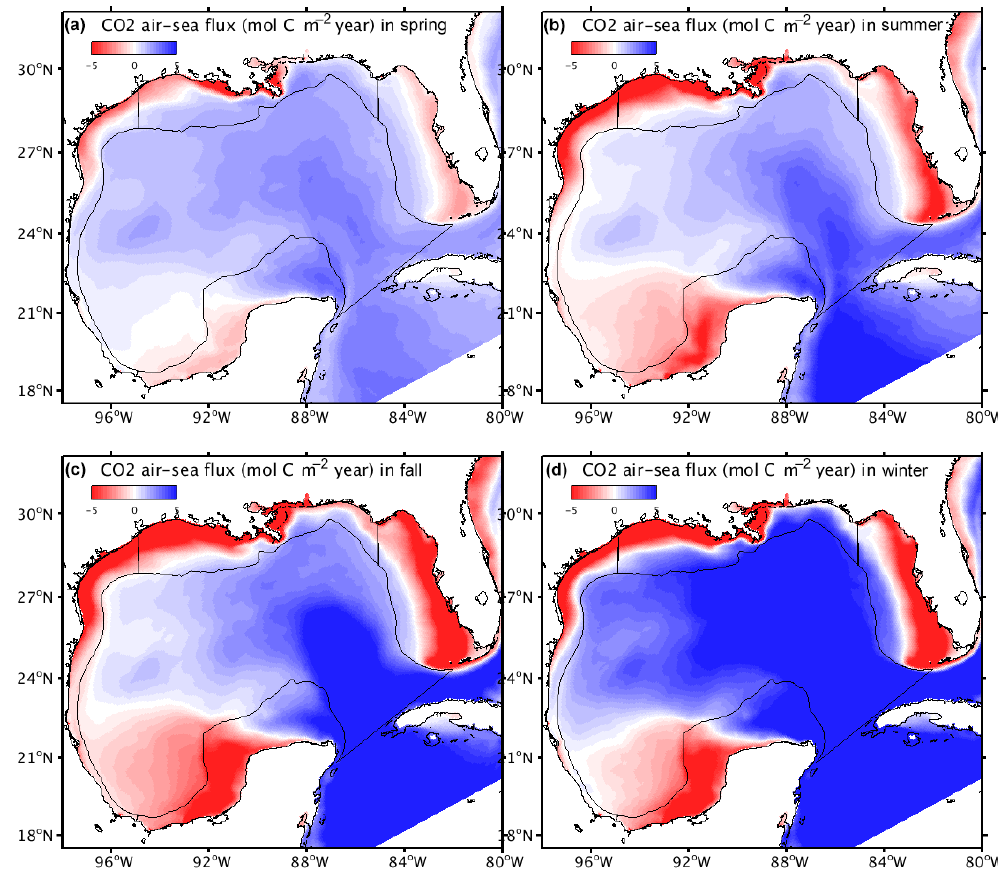
Figure 7. Six-year (2005–2010) model (control run) mean air–sea CO 2 flux in the Gulf of Mexico during (a) spring, (b) summer, (c) fall, and (d) winter. Blue color indicates where the ocean is a sink for CO 2 ; red color indicates where the ocean is a